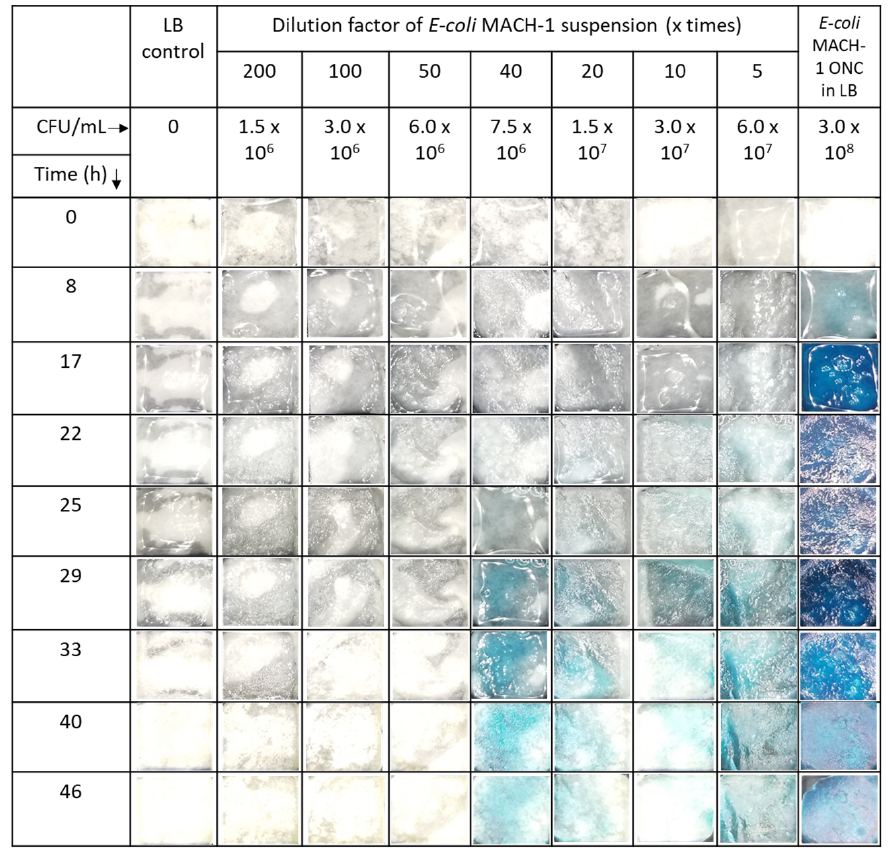
Figure 4. Photographs of visible color change of chitosan-g-X-Gluc coated paper after incubation in differently concentrated E. coli Mach1 suspensionsin LB.